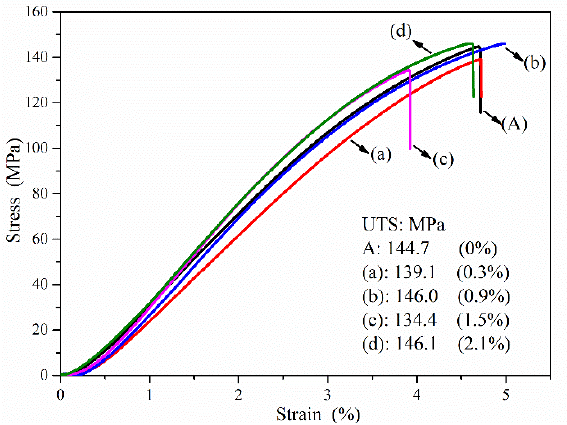
Figure 5. Tensile strength of the strain-stress curve of the samples: (A) is the blank samples; and (a) – (d) are 0.3 – 2.1% resin-added samples.